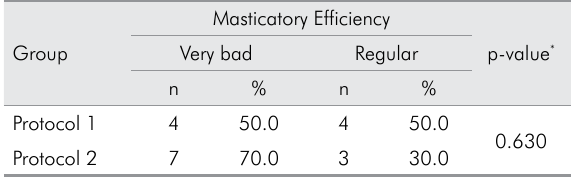
Mean ± Standard deviation. *Fisher’s exact test of independence.